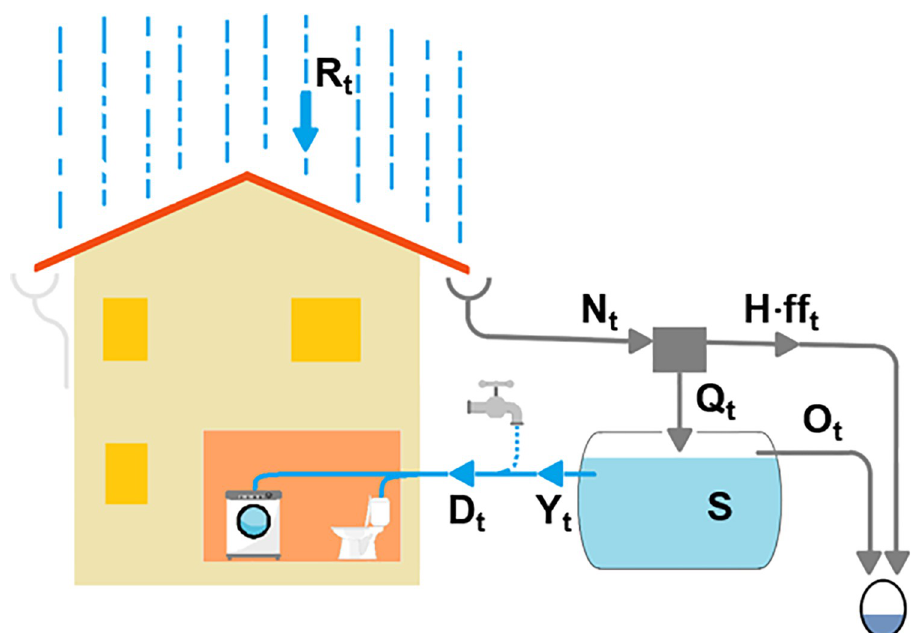
Fig 1. Scheme of a domestic rainwater harvesting system.